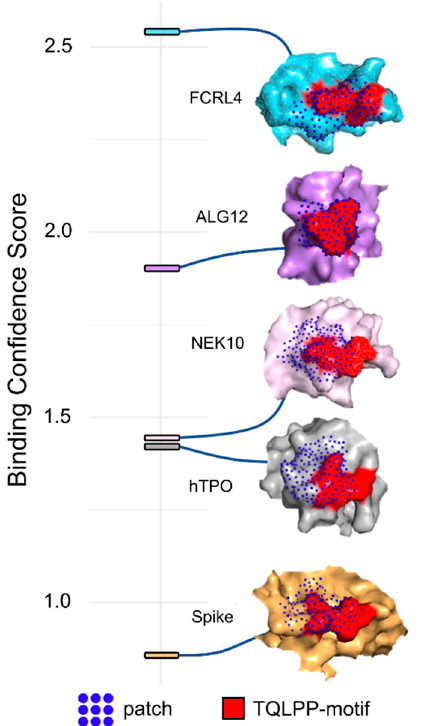
Figure 5. Predicted interaction patches between TN1 Fab antibody (PDB id: 1V7N) and the TQLPP motif. The best (lowest) binding confidence score is shown for Spike (PDB id: 7LQV, chain A, beige), hTPO (PDB id: 1V7N, chain X, gray), NEK10 (Uniprot: Q6ZWH5, pink), ALG12 (Uniprot: Q9BV10, purple), and FCRL4 (Uniprot: Q96PJ5, light blue). For all, red indicates the TQLPP motif and dark blue dots represent the surface points included in the predicted MaSIF patches.